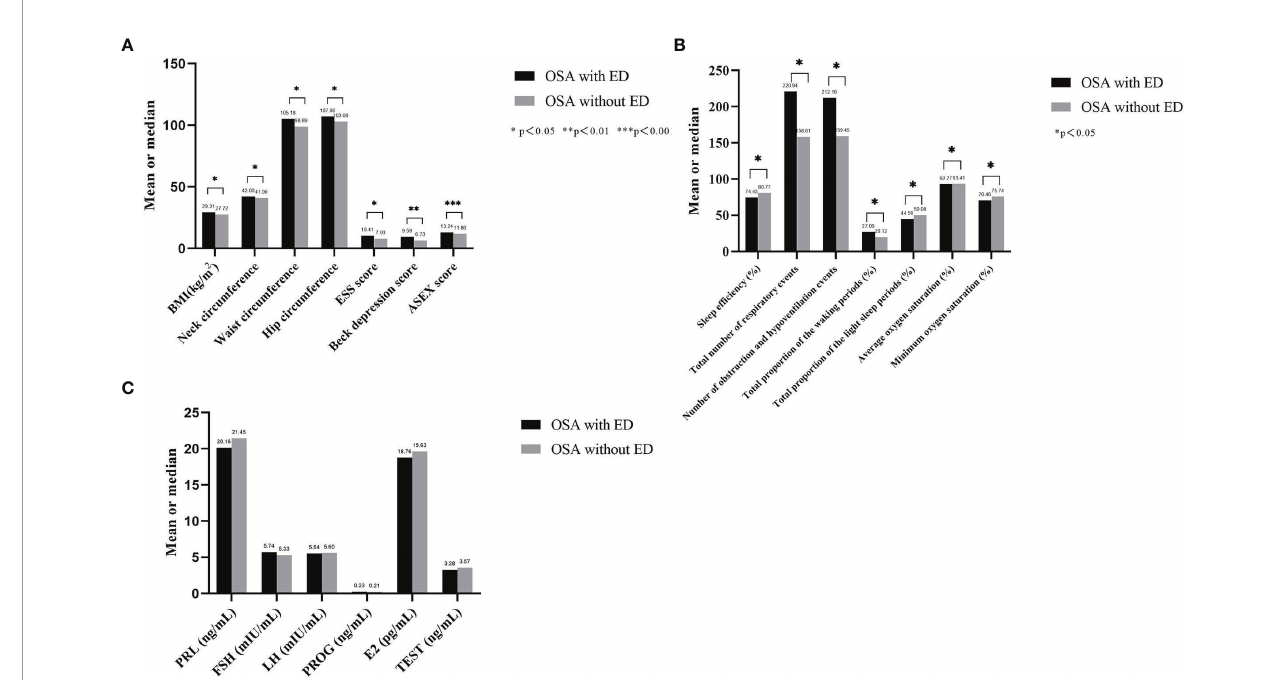
FIGURE 4 | Basic related clinical phenotypes, PSG data and sex hormone secretion of OSA with ED and without ED. (A) BMI, neck circumference, waist circumference, hip circumference, ESS score, Beck depression score and ASEX score were higher in the OSA with ED group than in the OSA without ED group; (B) Sleep ef fi ciency, average oxygen saturation and minimum oxygen saturation were signi fi cantly lower in the OSA with ED group than in the OSA without ED group. Moreover, the total number of respiratory events, number of obstruction and hypopnea events, total proportion of the waking periods and total proportion of the light sleep periods were signi fi cantly higher in the OSA with ED group than in the OSA without ED group; (C) The secretion levels of PRL, FSH, LH, PROG and TEST were not signi fi cantly different between the groups.